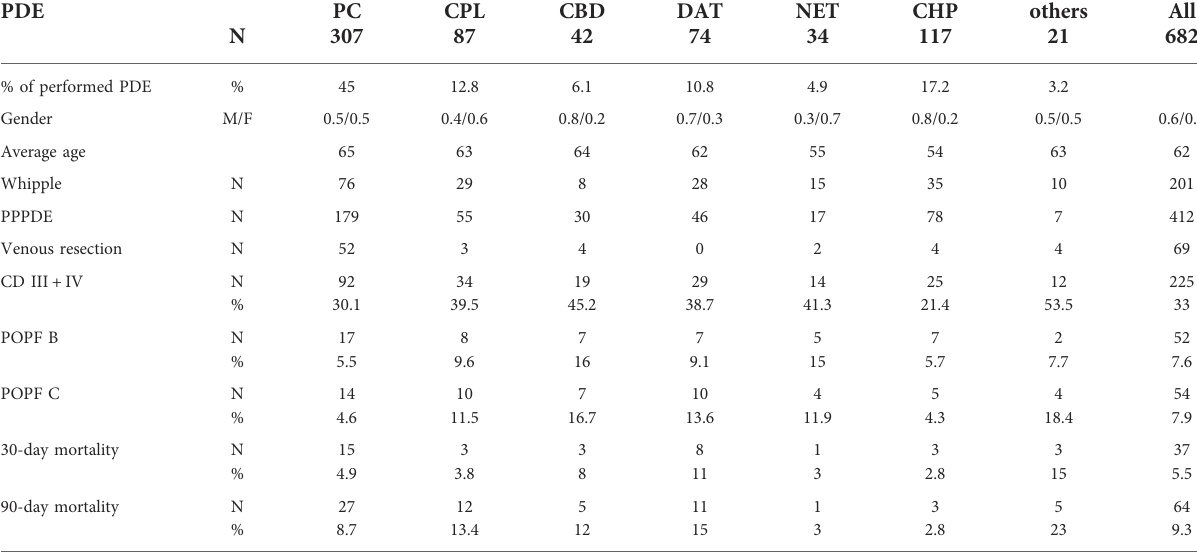
TABLE 1 Baseline characteristics of the patients who underwent the PDE in the 2008 – 2020 period.